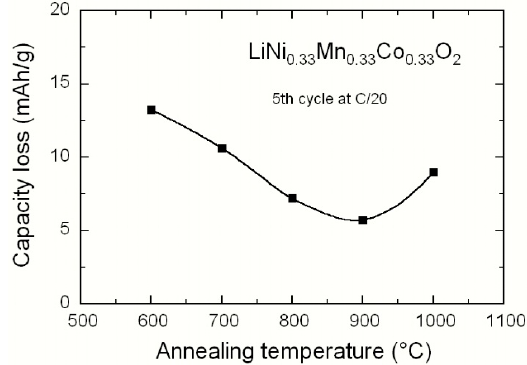
Figure 16. Initial capacity loss of LiNi 1/3 Mn 1/3 Co 1/3 O 2 electrodes cycled at C/20 as a function of the annealing temperature.